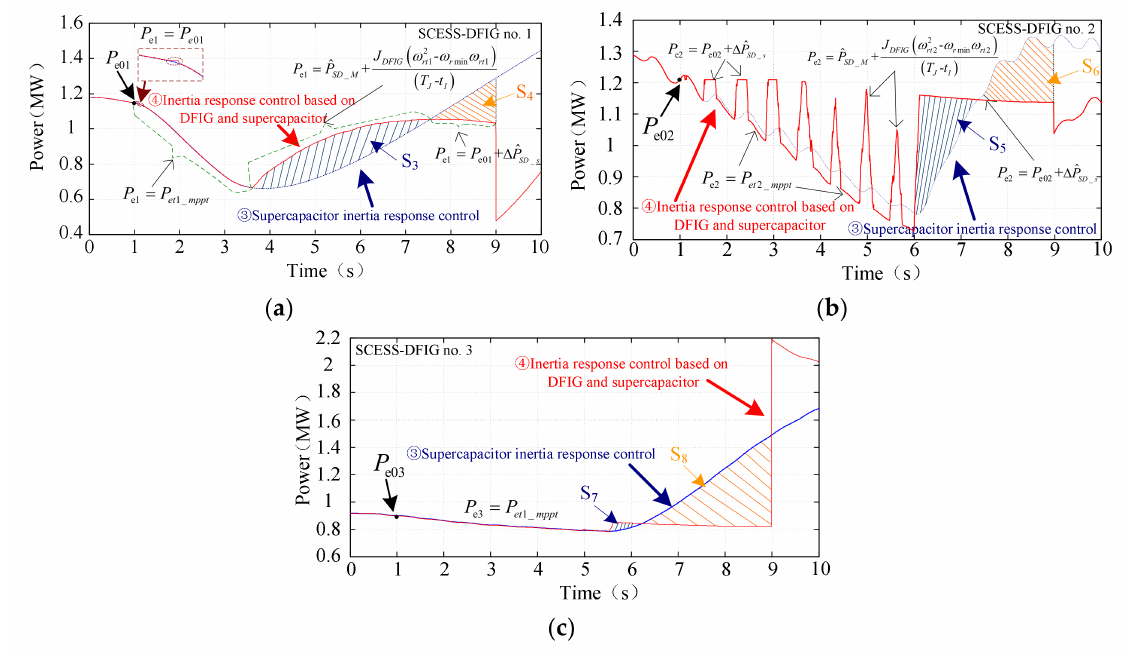
Figure 16. Comparison of DFIG output electric power P e under different control strategies: ( a ) DFIG output electric power P e 1 under different control strategies for no. 1 SCESS-DFIG; ( b ) DFIG output electric power P e 2 under different control strategies for no. 2 SCESS-DFIG; ( c ) DFIG output electric power P e 3 under different control strategies for no. 3